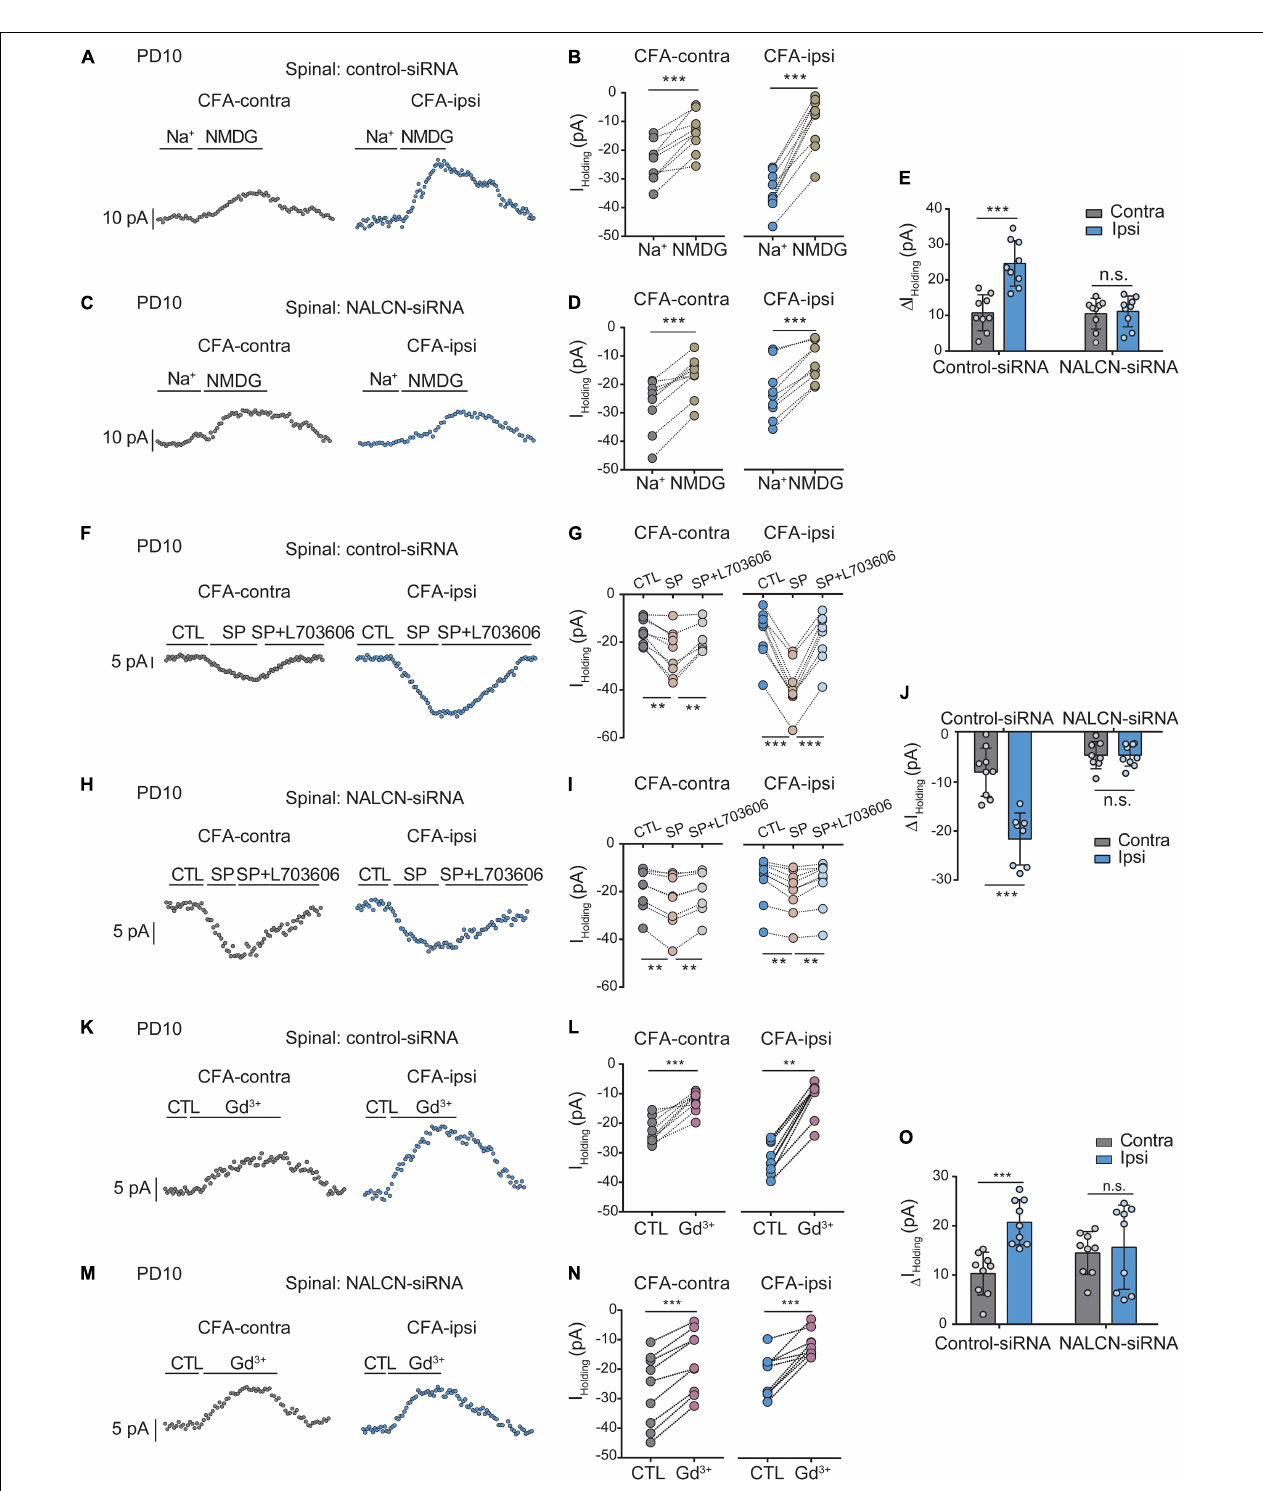
FIGURE 6 | Na + -mediated currents and gadolinium (Gd 3 + )-inhibited I holding in neurons of spinal cord increase after injection of CFA. Sensory neurons of spinal dorsal cord were recorded at holding potential of –60 mV. (A) The representative real-time analysis of I holding in neurons from the rats that received control-siRNA combined with injection of CFA. The I holding was extracted by replacing extracellular Na + with NMDG. (B) The I holding in spinal cord neurons of control siRNA-treated rats was analyzed before and after replacement with NMDG. (C) The representative real-time analysis of holding currents in neurons from the rats that received NALCN-siRNA combined with injection of CFA. The I holding was extracted by replacing extracellular Na + with NMDG. (D) The I holding in spinal cord neurons of NALCN siRNA-treated